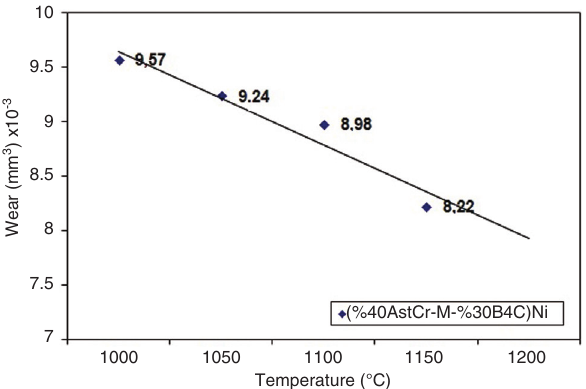
Figure 3 Density changes with respect to sintering temperature.